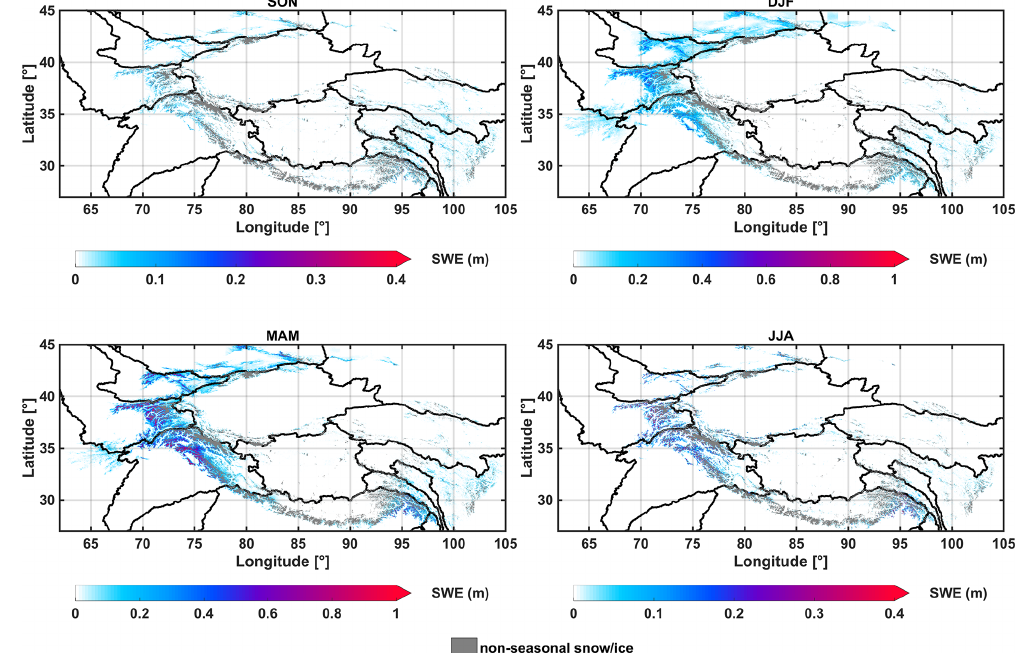
Figure 5. Map of mean seasonal SWE climatology in SON (September, October, November), DJF (December, January, February), MAM (March, April, May) and JJA (June, July, August), with non-seasonal snow and ice pixels masked out (gray).